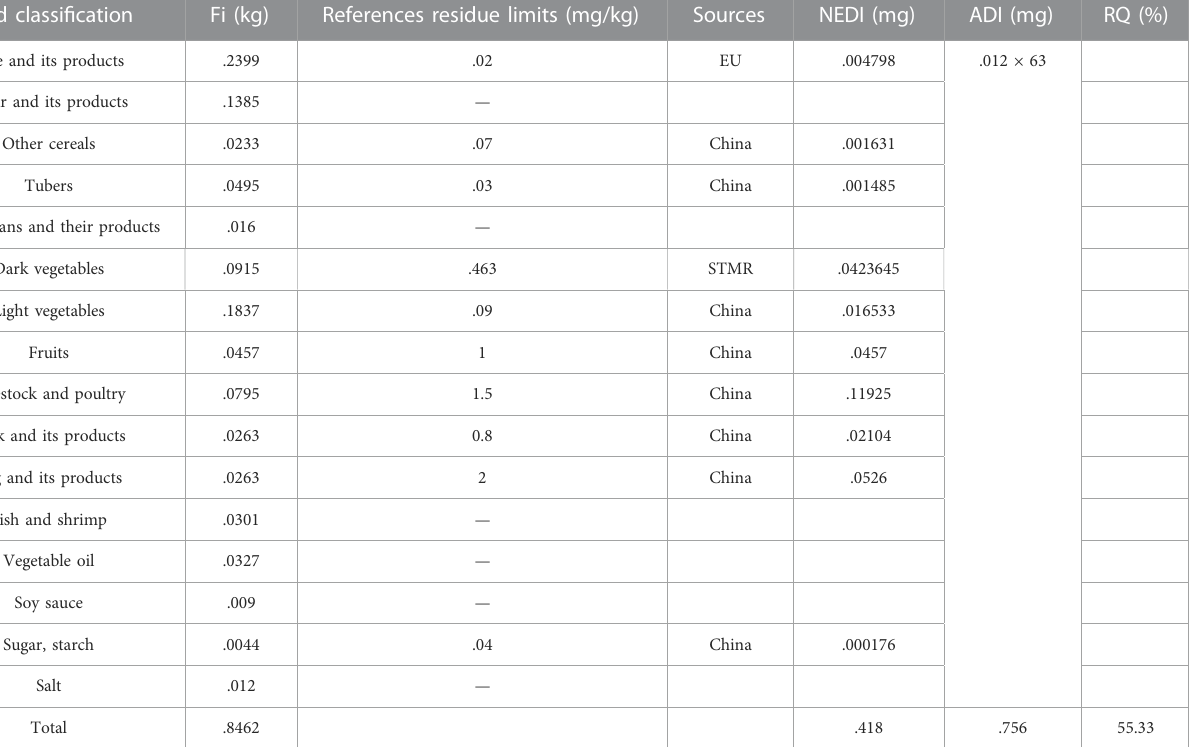
TABLE 6 The long-term dietary exposure risk assessment of fl uopyram. Food classi fi